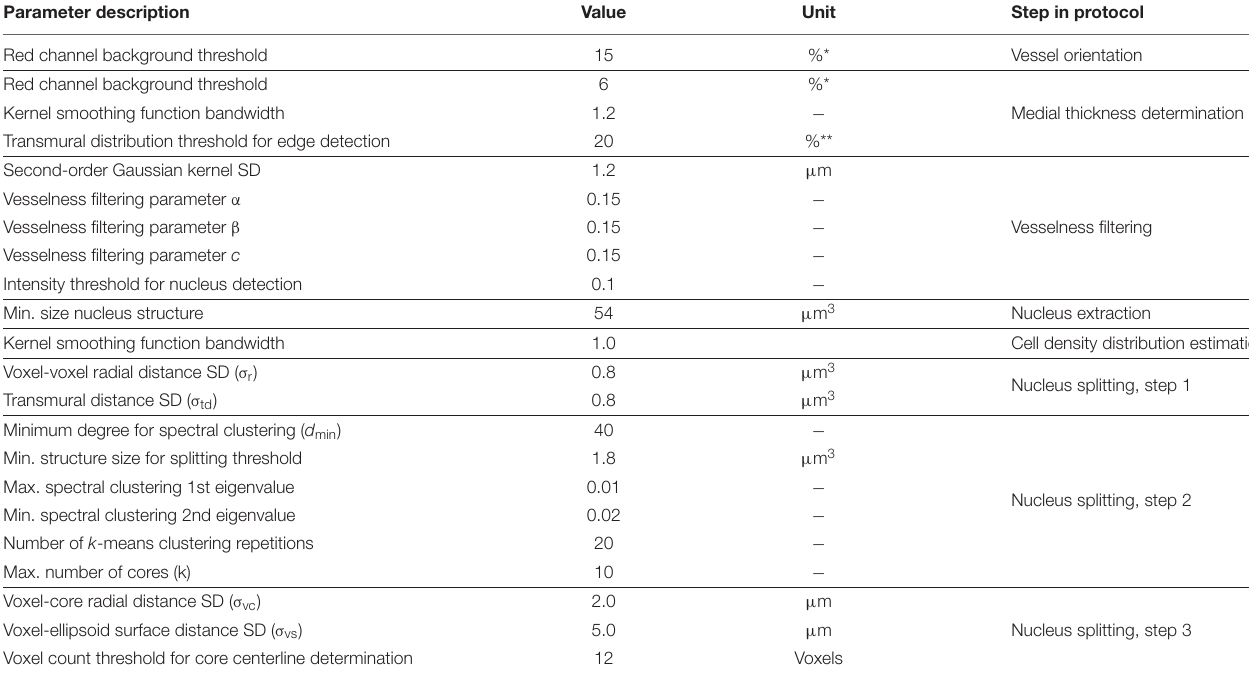
TABLE 1 | Parameter values for nucleus quantification from TPLSM 3D images. Parameter